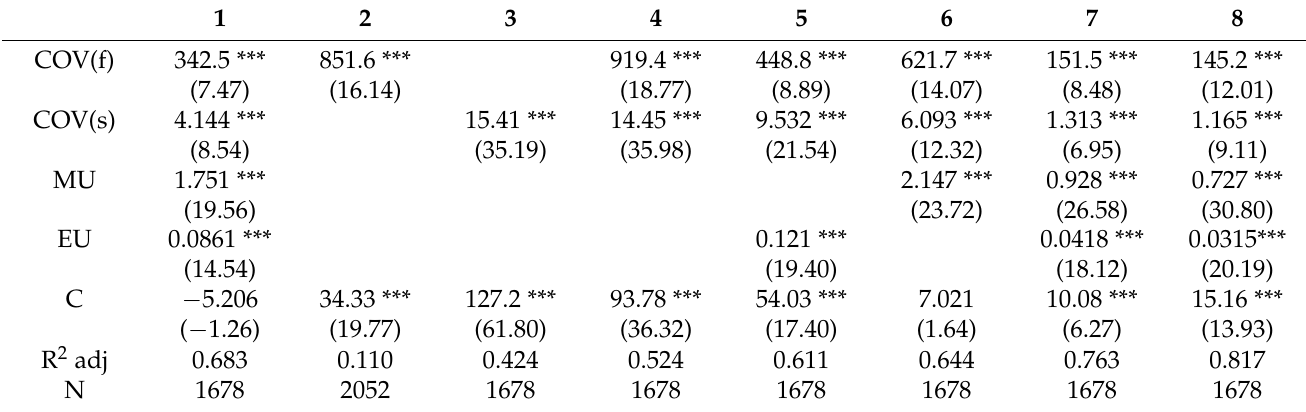
Table 10. COVID-19 death announcements, 2-week speed, and oil price volatility, world panel